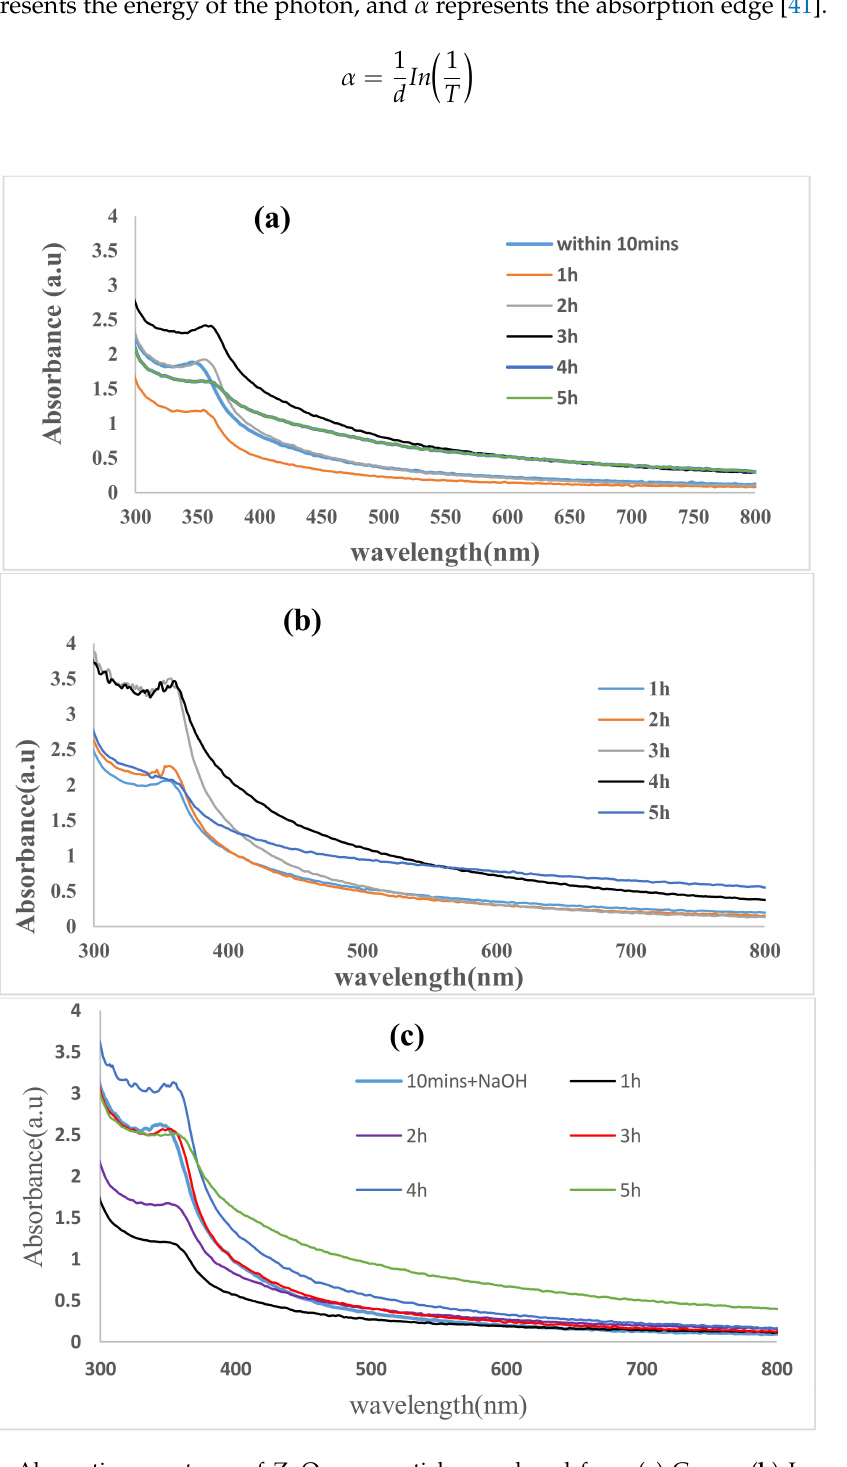
Figure 2. Absorption spectrum of ZnO nanoparticles produced from ( a ) Grape, ( b ) Lemon and ( c ) Orange peel extract within 10 min, within 10 min of introducing NaOH, 1 h, 2 h, 3 h and 4